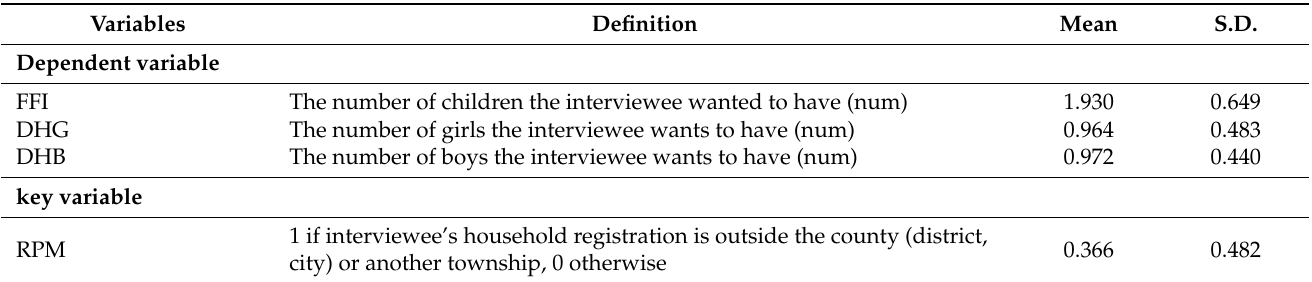
Table 1. The definitions and descriptions of the variables in the